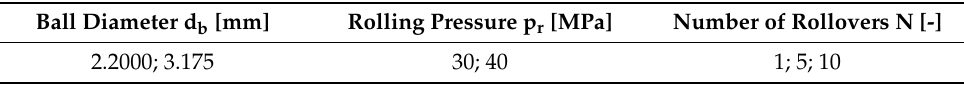
Table 3. Process parameters used in experimental investigations.